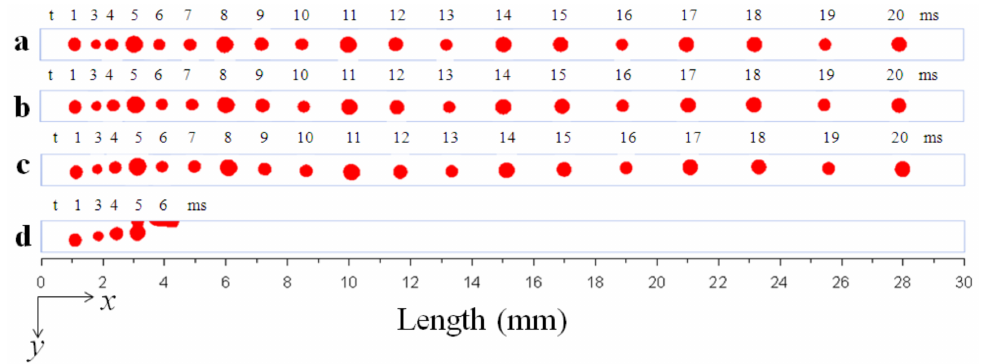
Figure 5. Water spreading on the MEA surface for various water initial locations in the flow channel: ( a ) D = 0, the conventional case; ( b ) D = 0.05 mm, Case 1; ( c ) D = 0.1 mm, Case 2; ( d ) D = 0.15 mm, Case 3. D is the distance from the water spreading center to the MEA central line on the MEA surface. As is known, the flow is laminar in the gas flow channel. The laminar boundary layer